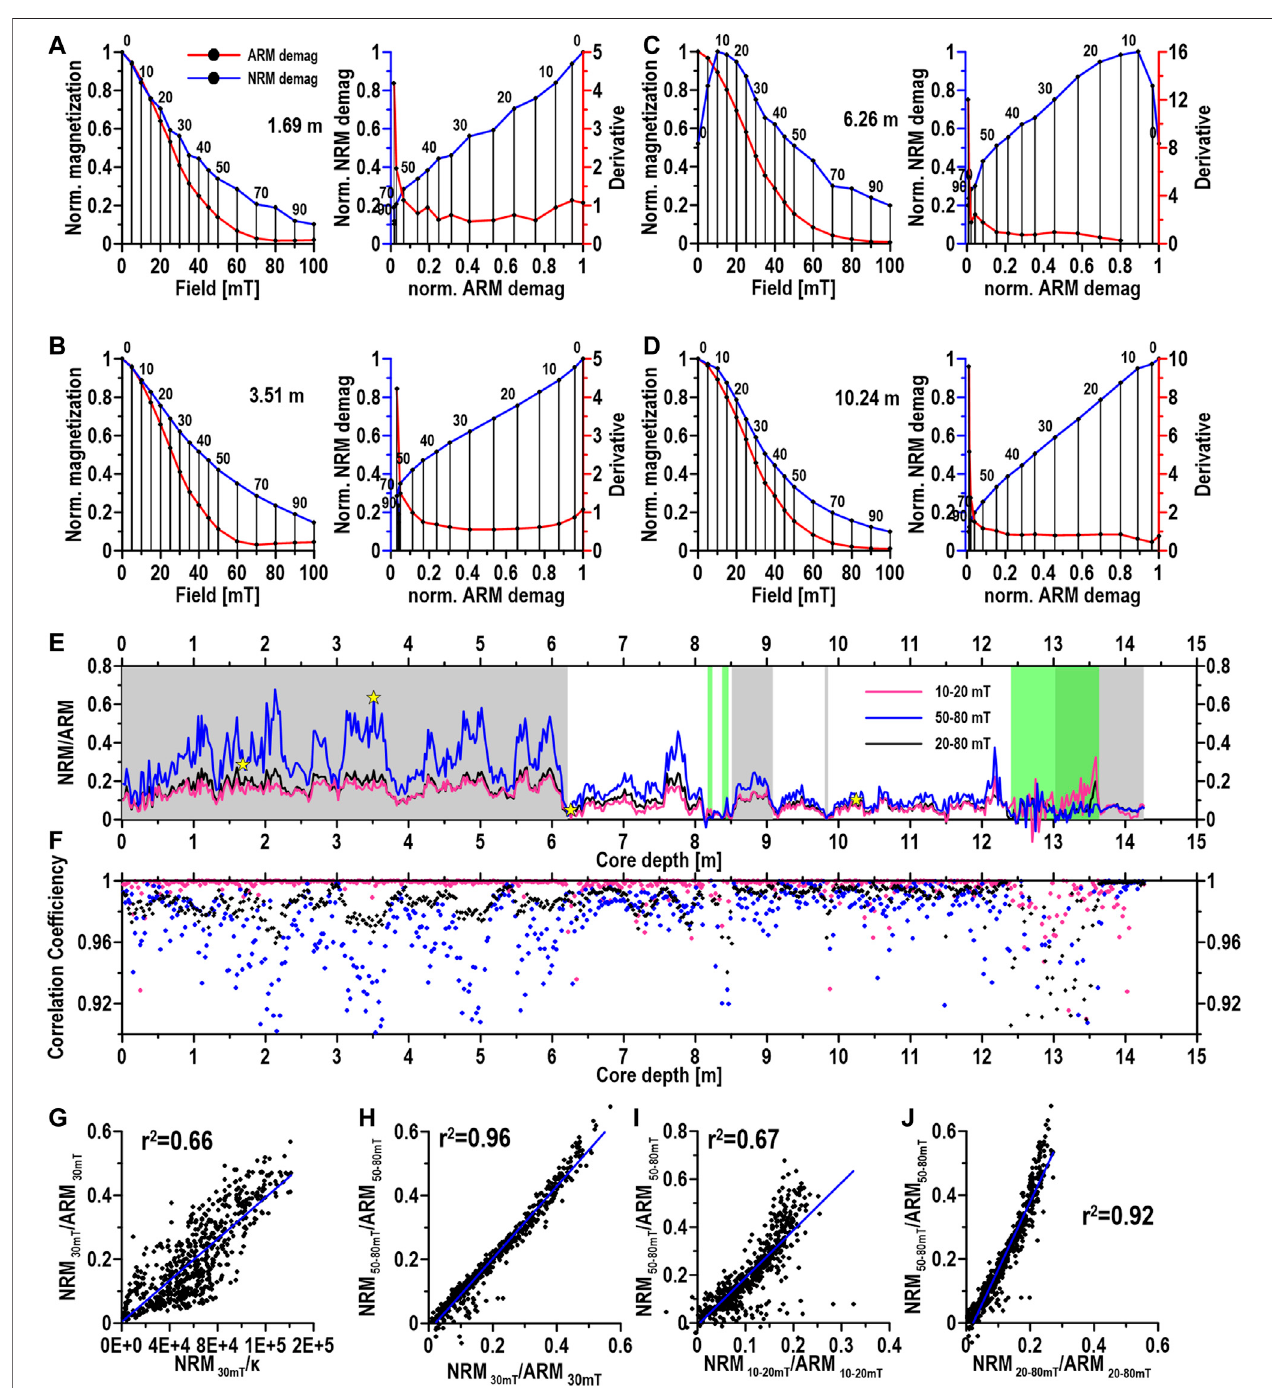
FIGURE7| Analyticaldiagramsfortheselectionthemostappropriate RPInormalization method: (A – D) LeftpanelsillustratenormalizedNRM(blue)andARM(red) AF demagnetization curves for representative samples of core SO264-19-2 (marked by yellow stars in Panel 7E). Right panels show normalized NRM vs. normalized ARM AF demagnetization levels (in blue) and their derivatives (in red). (E) Relative paleointensity (RPI) records normalized in three different ways: NRM 10 – 20mT / ARM 10 – 20mT (pink), NRM 50 – 80mT /ARM 50 – 80mT (blue), NRM 20 – 80mT /ARM 20 – 80mT (black). (F) Corresponding linear correlation coef fi cients (r) marked by dots of the same color. (G – J) Biplots of RPI values calculated by different normalization methods with corresponding correlation coef fi cients r 2 and linear regression curves (blue).